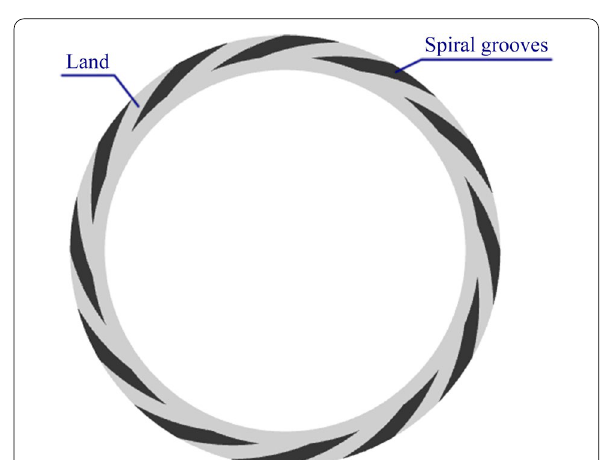
Figure 2 Spiral grooves on the rotor